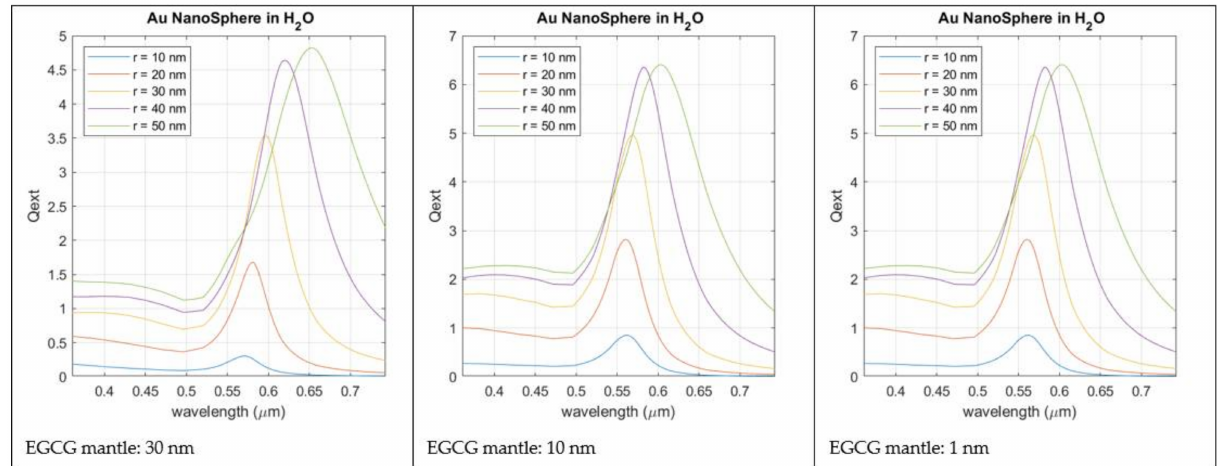
Figure 9. Simulated LSPR intensity for AuNPs with increasing dimensions (radius between 10 and 50 nm). Gold nanospheres are immersed in pure water and have a capping layer of EGCG with a thickness between 1 and 30